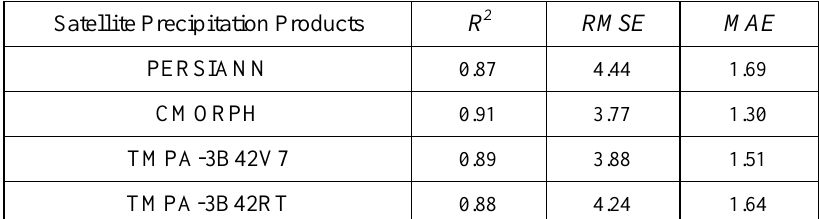
Table 3. The results of runoff simulation with satellite rainfall estimates and